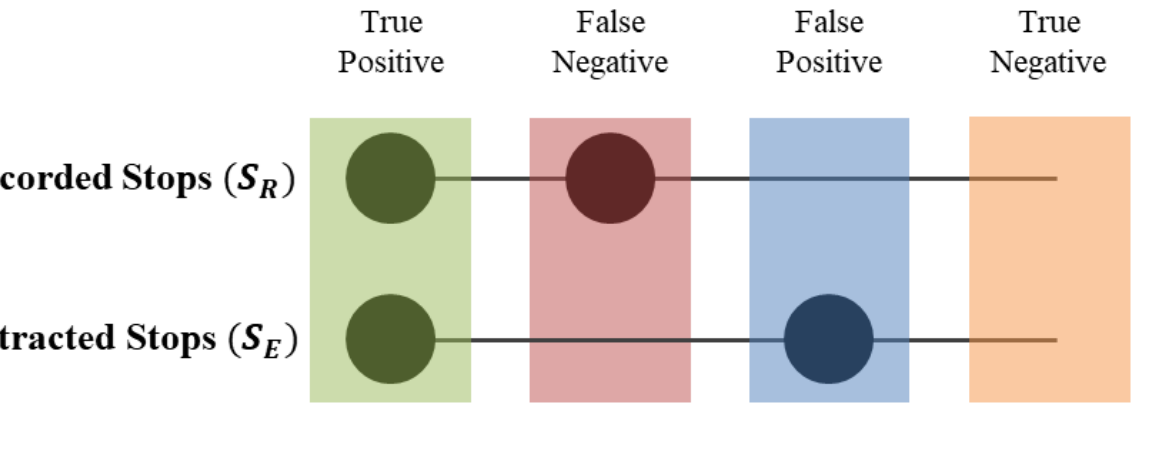
Figure 2. Comparison of the stops recorded in the travel diary versus the stops extracted from the GPS